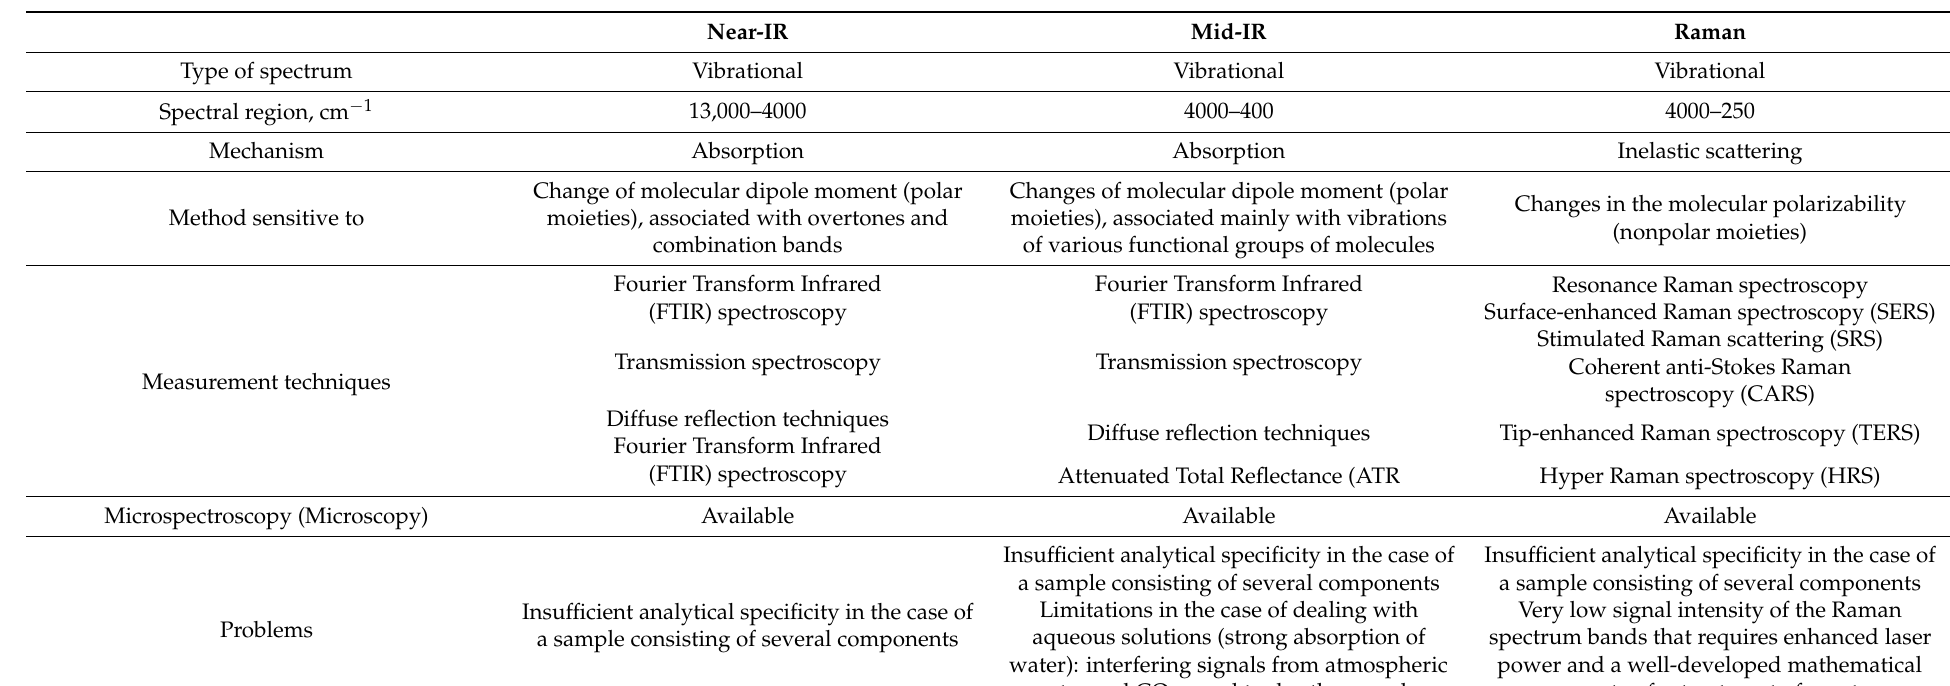
Table 2. Peculiar properties of vibrational